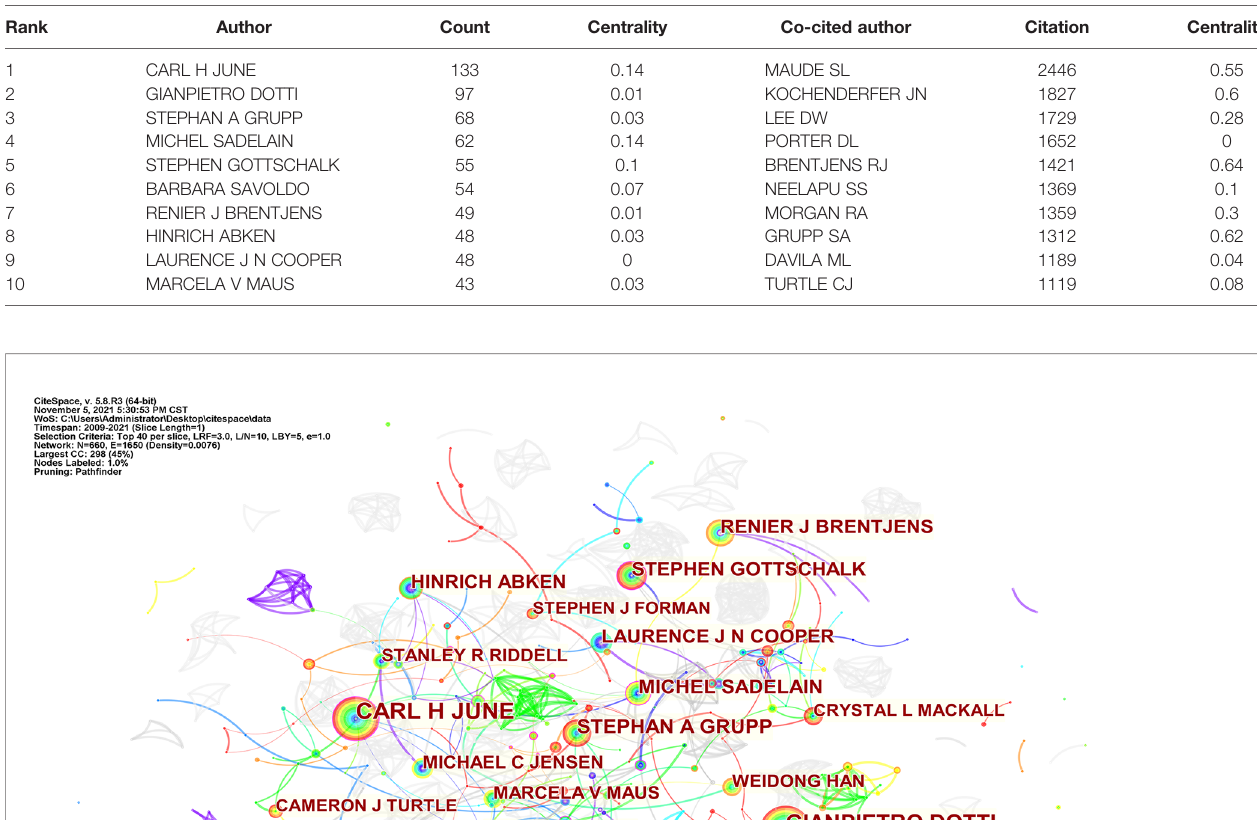
costimulation,4-1BBcostimulation,suicidegene,andsafetyswitch.